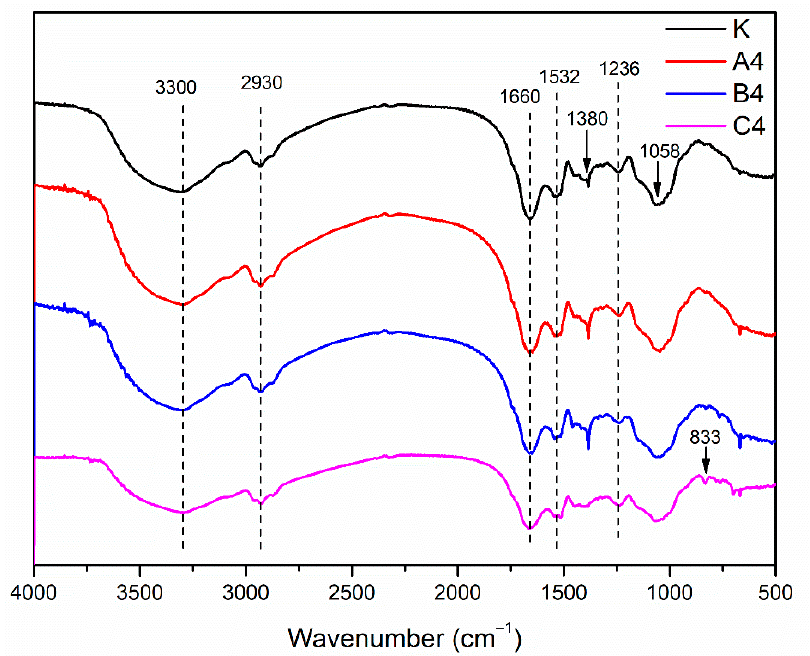
Figure 3. FTIR spectrum of the different new-made soy meal samples: K (SM adhesive), A4 (SM/5% preservative A), B4 (SM/5% preservative B), and C4 (SM/5% preservative C).